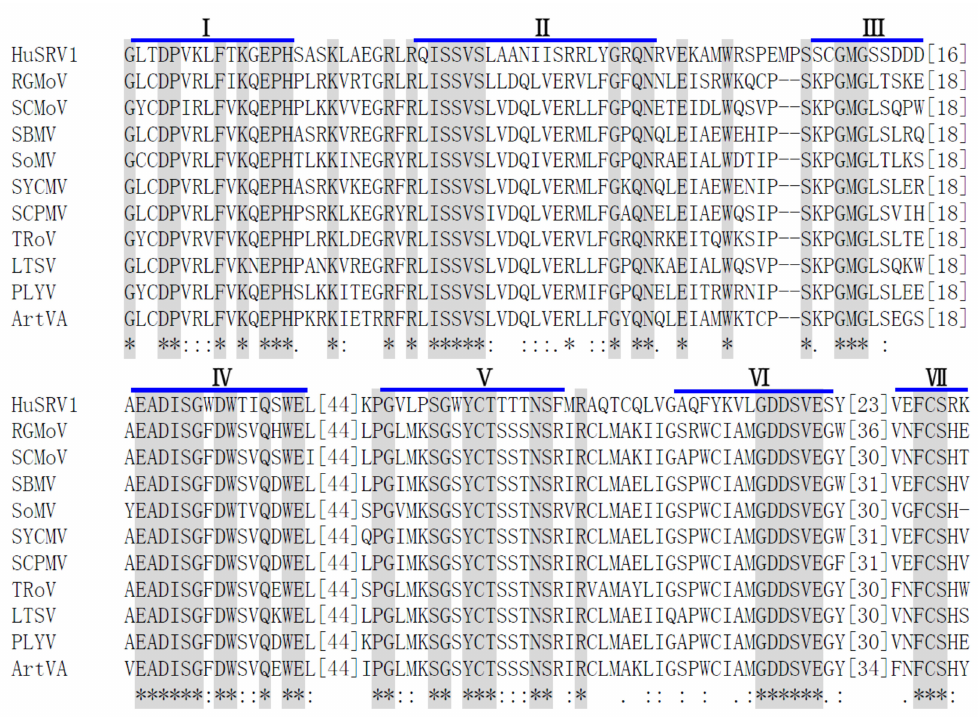
Figure 4. Alignment of the conserved RdRp amino acid motifs of HuSRV1 and corresponding regions in the selected viruses from Sobemovirus . Seven motifs (I-VII) are detected in the sequence of the conserved RdRp region. Identical residues are indicated by asterisks and highlight; conserved and semi-conserved amino acid residues are indicated by colons and dots, respectively. Numbers in square brackets correspond to the number of amino acid residues separating the motifs. Abbreviations of representative viruses of genus Sobemovirus are given in Table